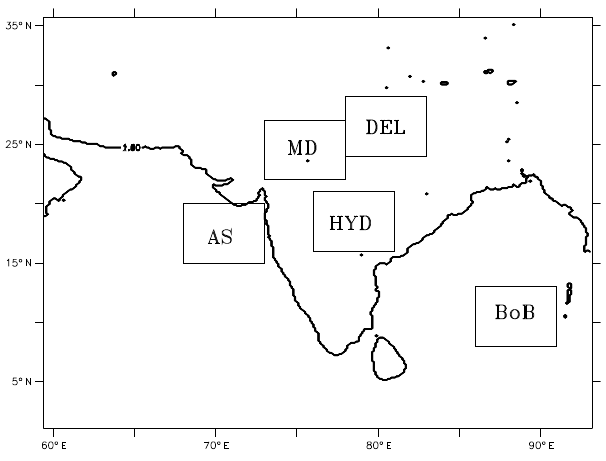
Figure 11. The 5 ◦ × 5 ◦ regional boxes considered for the CALIPSO analysis (AS is the Arabian Sea, BoB is the Bay of Bengal, HYD is Hyderabad, MD is Mumbai and Delhi and DEL is